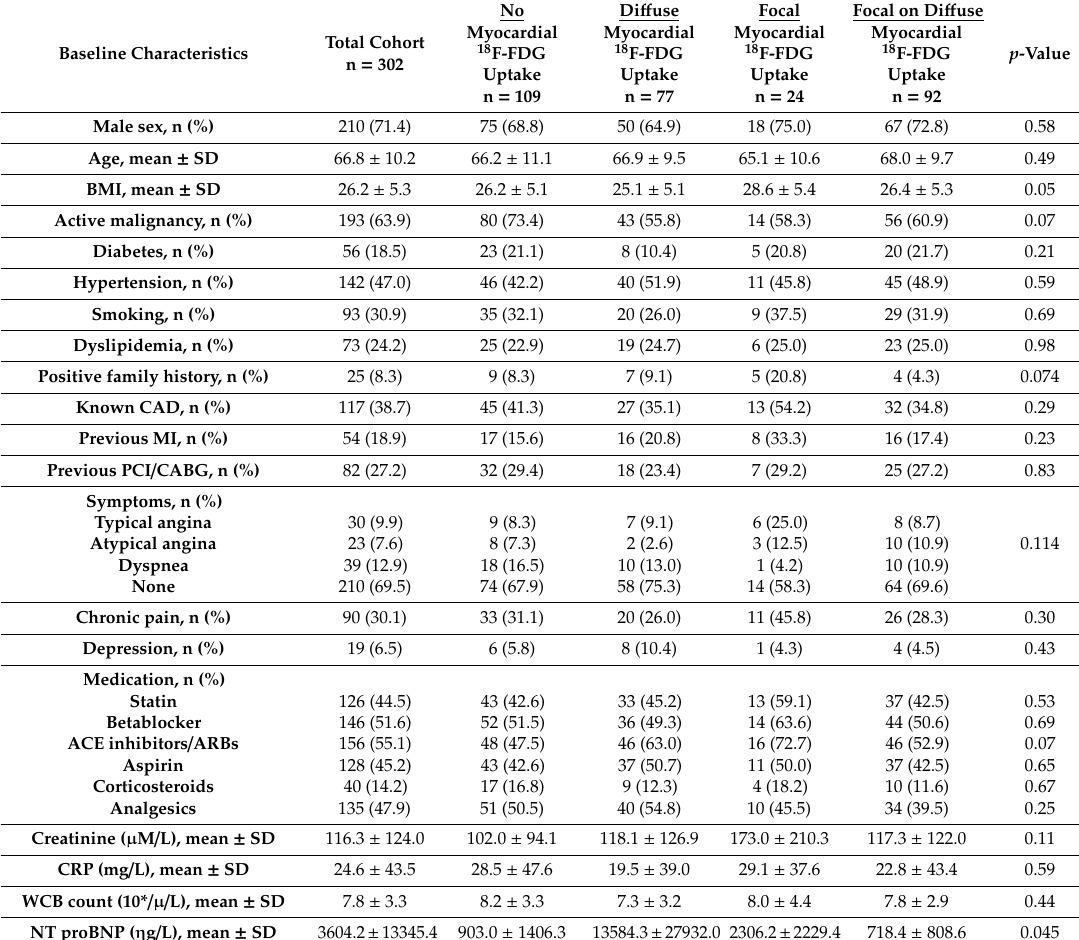
Table 1. Baseline demographics stratified by myocardial 18 F-FDG uptake pattern.